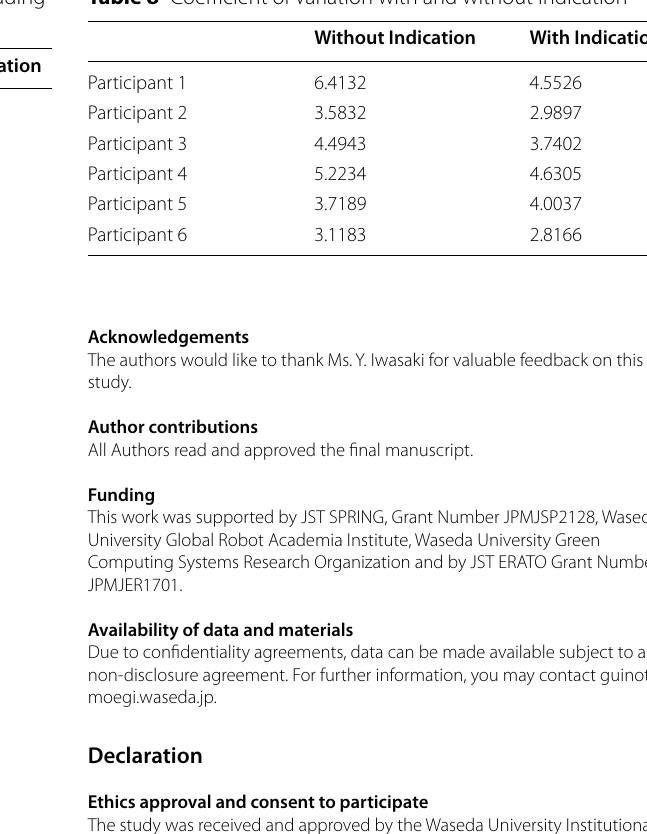
Table 8 Coefficient of Variation with and without